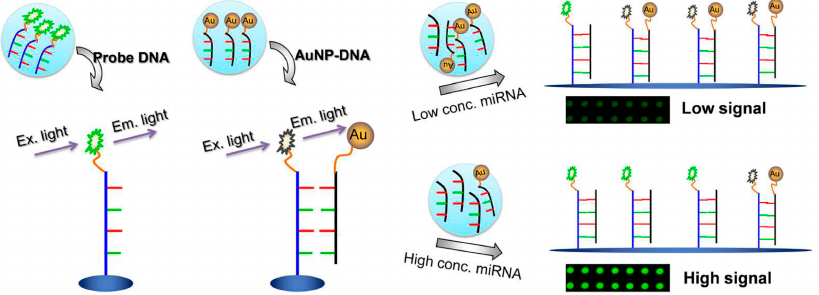
Figure 2. Schematic representation of miRNA-205 competitive detection based on fluorescence quenching of gold nanoparticles (AuNPs). Adapted from